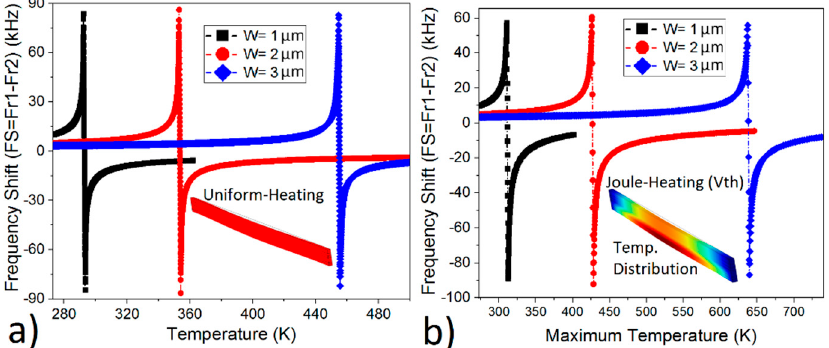
Figure 3. Frequency Shift (FS) with respect to 1 Kelvin (K) change by ( a ) Equation (1), and ( b ) COMSOL, when thickness (W) changes from 1 µm to 3 µm for Device 1 with a device length of 120 µm.